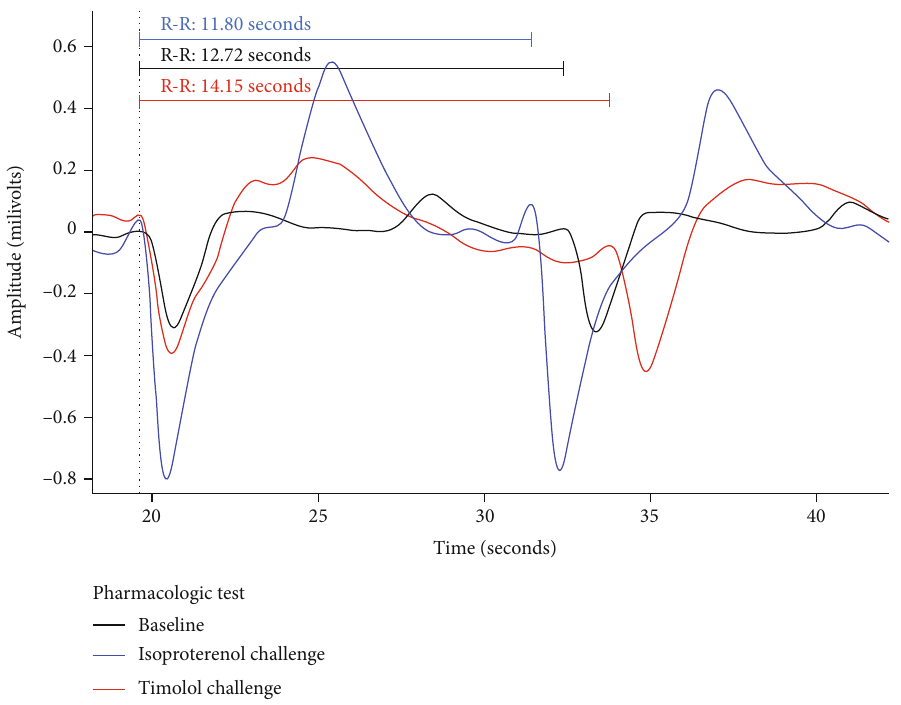
Figure 6: Unipolar electrograms from engineered graft. Superimposed colorized tracings depicting unipolar voltage electrograms (UVE) acquired utilizing a multielectrode array on one engineered cardiac graft. The black tracing exhibits the control depolarization (QS wave) and repolarization (T wave) waveforms via UVE collected without any pharmacologic manipulation. The blue tracing exhibits a UVE obtained from the same engineered graft exposed to isoproterenol (1 E -2 M); a physiologic shortening of the QS-QS interval and QT interval is observed. The red tracing exhibits a UVE obtained from the same engineered graft exposed to timolol (1 E -4 M); a physiologic lengthening of the QS-QS interval and QT interval is